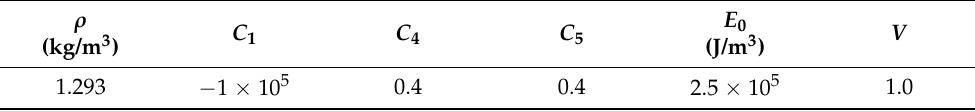
Table 4. Parameters of air and equation of state